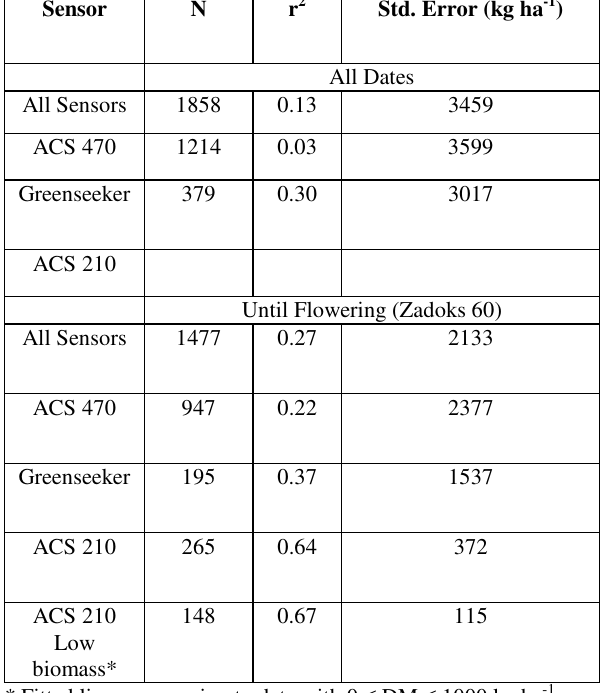
Table 3. Regression results for Total Above Ground Dry Matter (kg ha -1 ) on